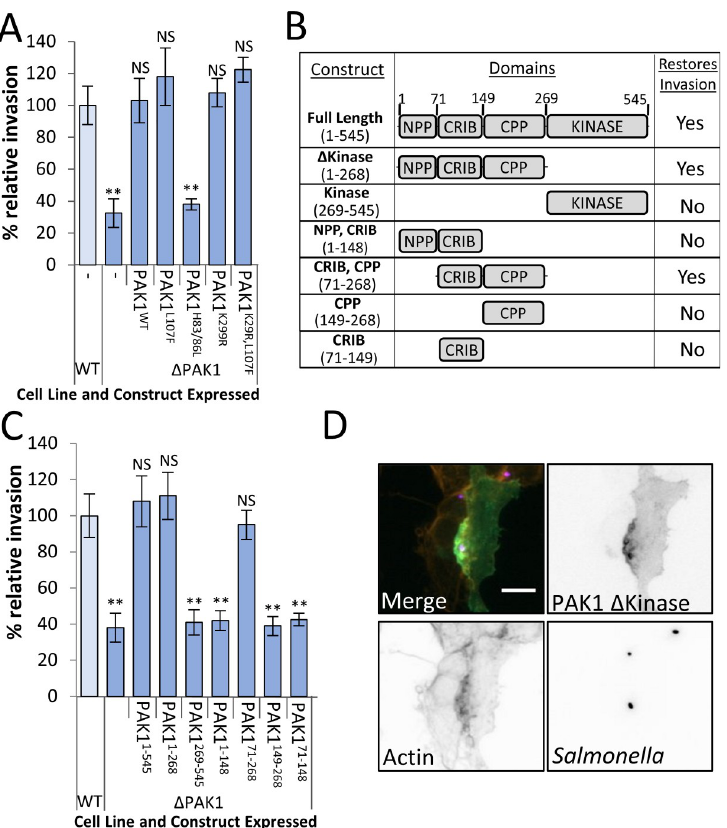
Fig 2. PAK kinase domain is dispensable for Salmonella uptake. (A) Invasion of WT Salmonella (20 mins) into WT and Δ PAK1 cells, or Δ PAK1 cells expressing either WT PAK1 (PAK1 WT ), constitutively open PAK1 (PAK1 L107F ), PAK1 that cannot bind GTPases (PAK1 H83/86L ), kinase dead PAK1 (PAK1 K299R ), kinase dead and constitutively open PAK1 (PAK1 K299R,L107F ). Invasion values relative to invasion in WT control cells. (B) Table summarising domain structure of PAK1: An N-terminal polyproline domain (NPP), a GTPase binding/autoinhibitory domain (CRIB/AID), a central polyproline domain (CPP) and a kinase domain (kinase). Also shown is the effect these constructs have on invasion when expressed in Δ PAK1 Hap1 cells, from the data in (C) . (C) Invasion of WT Salmonella (20 mins) into WT and Δ PAK1 Hap1 cells, as well as Δ PAK1 cells expressing PAK1 truncations summarised in (B): Full length (PAK1 1-545 ), Δ kinase (PAK1 1-268 ), Kinase (PAK1 269-545 ), NPP,CRIB/AID(PAK1 1-148 ), CRIB/AID, CPP (PAK1 71-268 ) CPP (PAK1 149-268 ) and CRIB/AID (PAK1 71-148 ). Invasion values relative to WT control cells. (D) Fluorescence microscopy of Δ PAK1 Hap1 cells transfected with Emerald-tagged PAK1 Δ kinase (green), infected (10 mins) with Alexa Fluor 350-stained Salmonella (blue). Actin stained with Texas-Red Phalloidin (red). Scale bar is 10 μ M. All Error bars indicate SD. NS–no significant difference, �� —P < 0.01, � P < 0.05 (ANOVA followed by a post hoc Dunnett’s